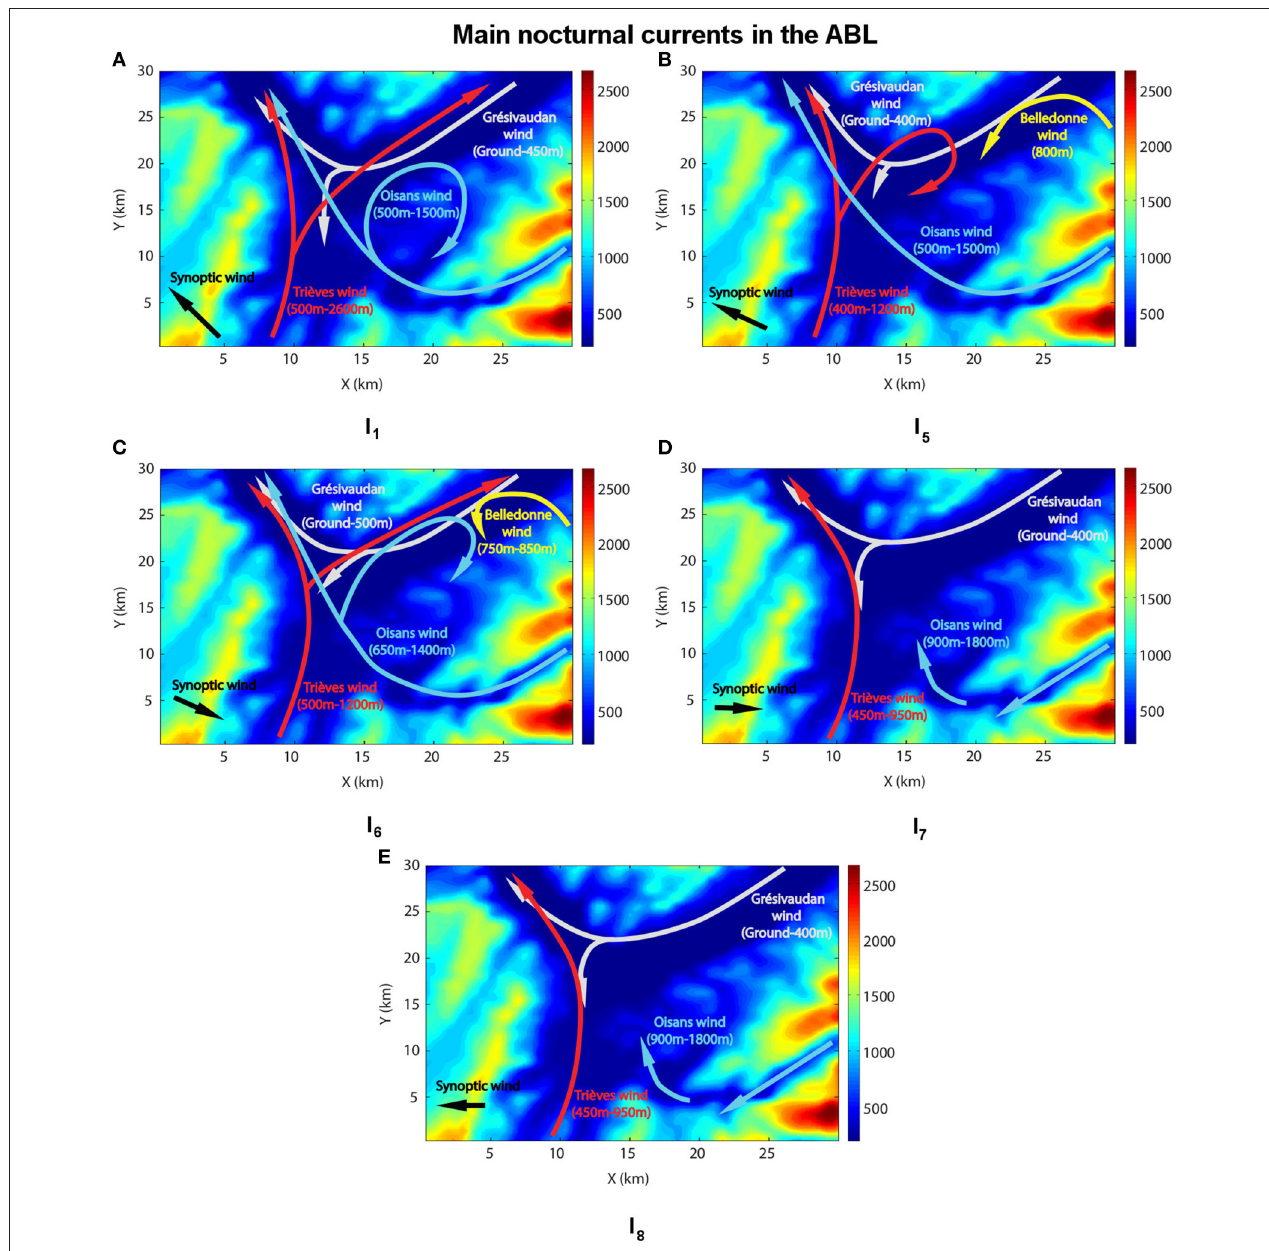
FIGURE 5 | Sketch of the main nocturnal currents during the heart of episode. (A) I 1 (November 7) ; (B) I 5 (December 15) ; (C) I 6 (December 28); (D) I 7 (January 13); (E) I 8 (February